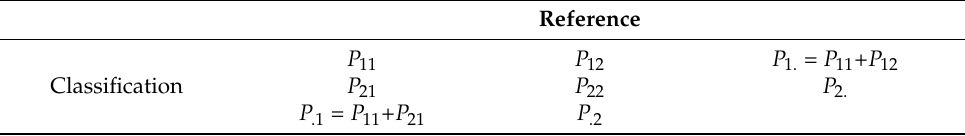
Table 5. Matrix of error or contingency adapted from